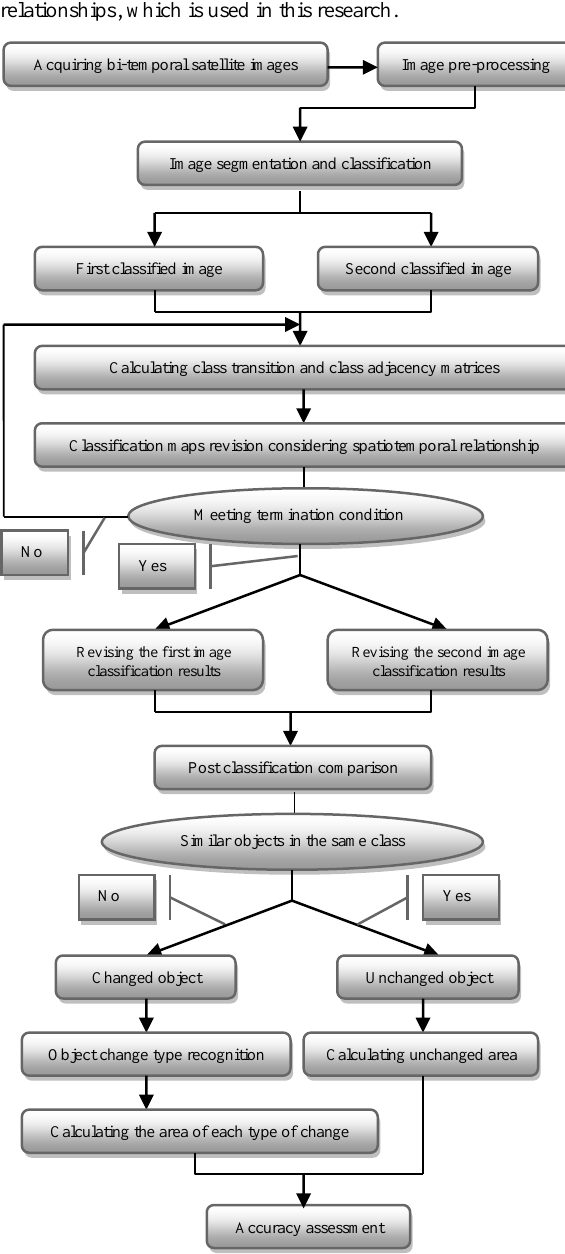
Figure 1. Object-oriented change detection